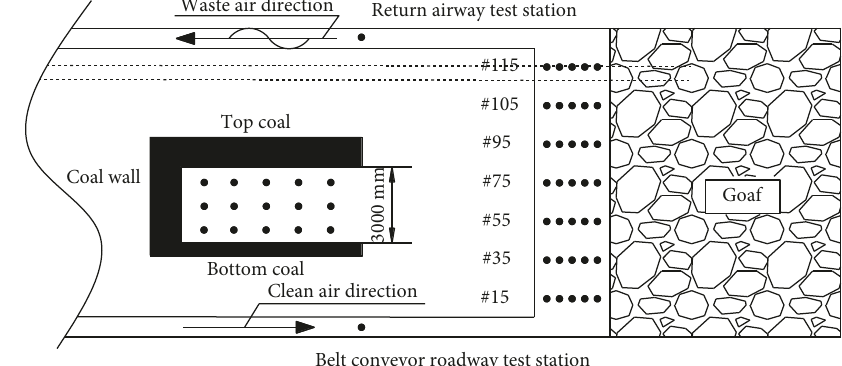
Figure 3: Measuring point arrangement of the face in the shape of the stereo grid.